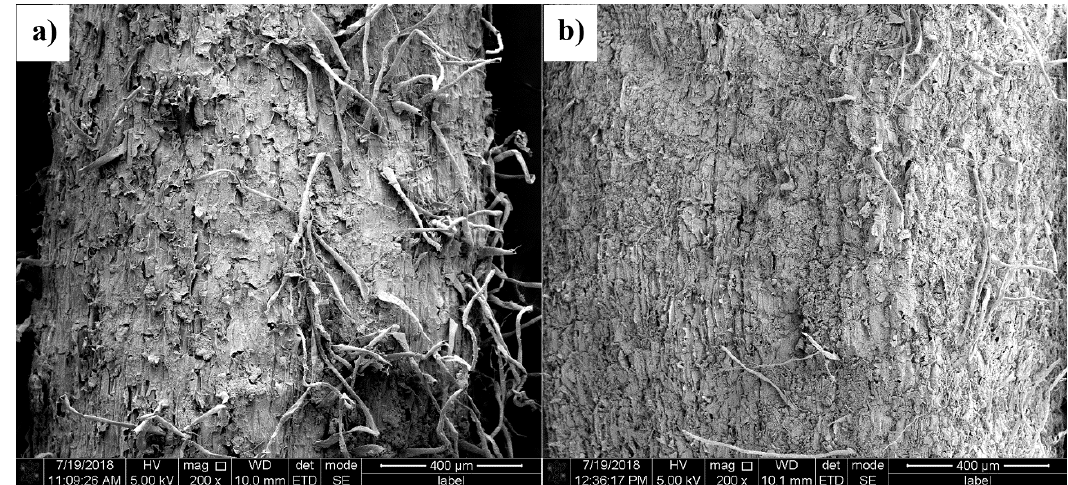
Figure 6. FESEM micrograph of surface root: ( a ) control; ( b ) Ni exposure.